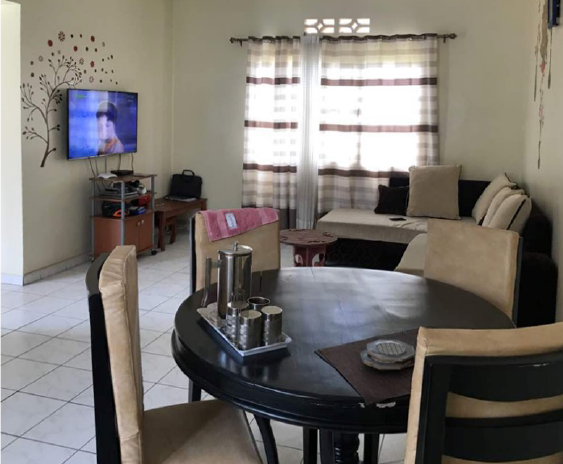
Figure 36. Twin House Type 1: Living room. Photograph by Manlio Michieletto.